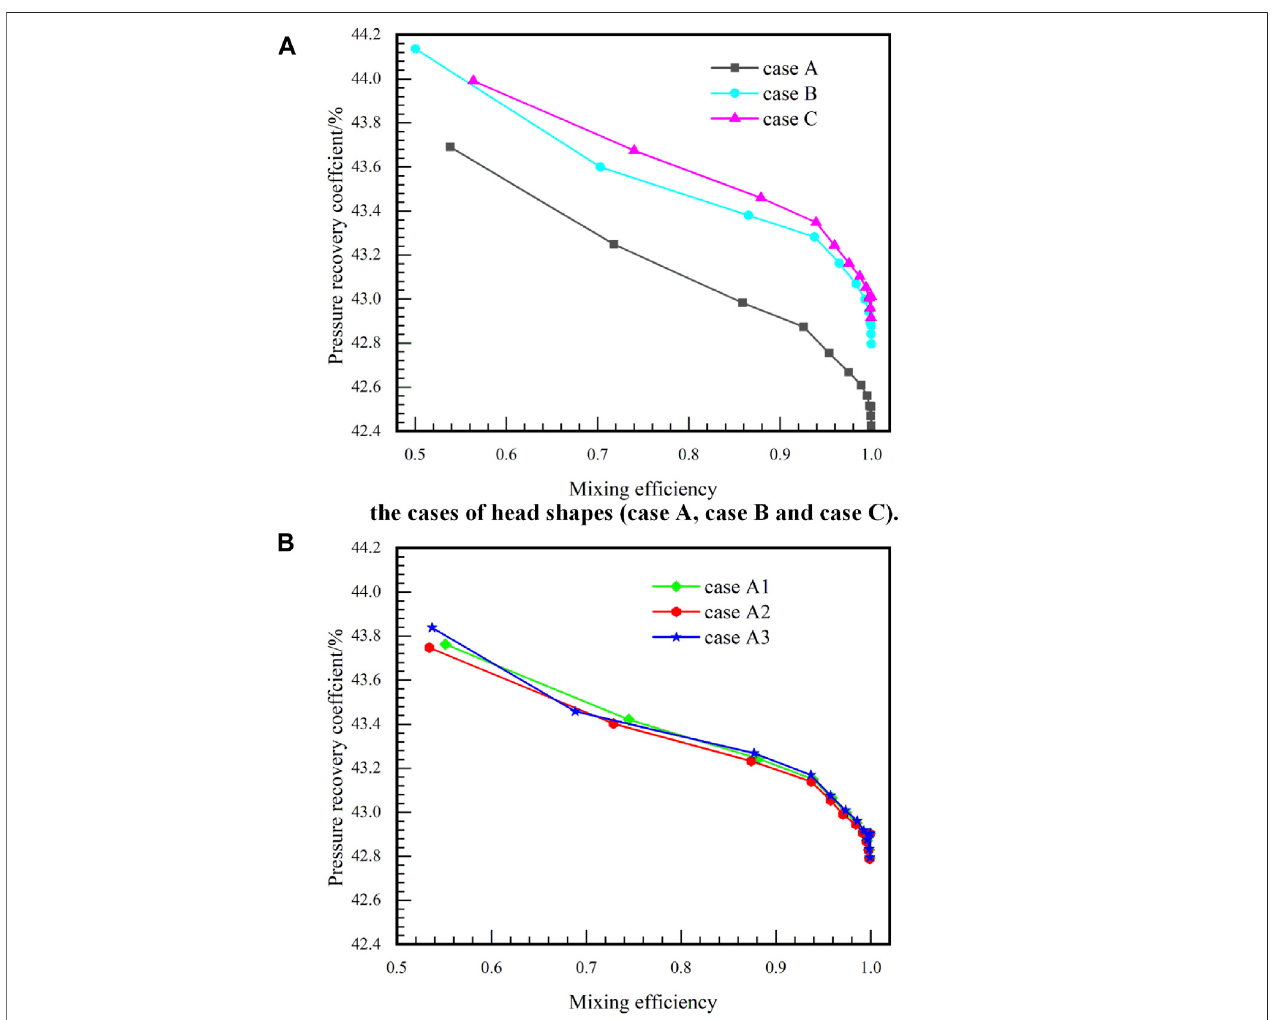
FIGURE 12 | Correlation between pressure recovery coef fi cients and mixing ef fi ciency on the y-z sections along the streamwise direction: (a) the cases of head shapes (case A, case B, and case C); (b) the cases of different exhaust inlet patterns (case A1, case A2, and case A3).